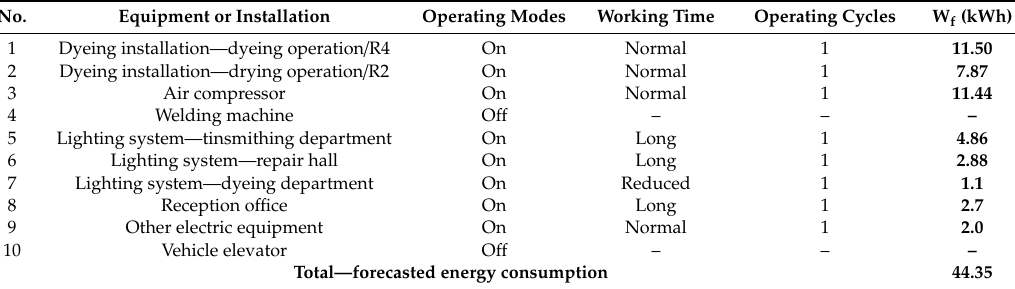
Table A6. The Decision Matrix and forecasted energy consumption for